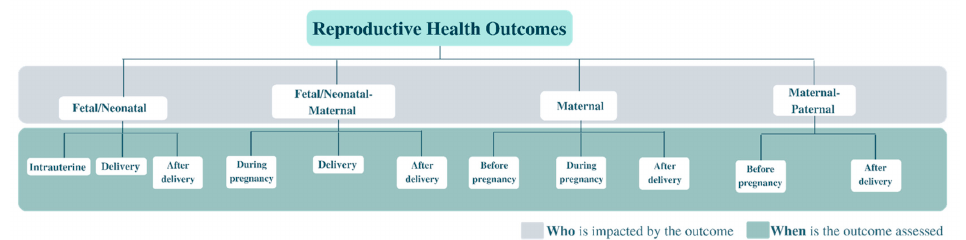
Figure 2. Sex-based framework of AYA cancer reproductive health outcomes based on systematic review (N = 21). Table 4. Summary of outcomes and their measures of association from included studies (N = 62).